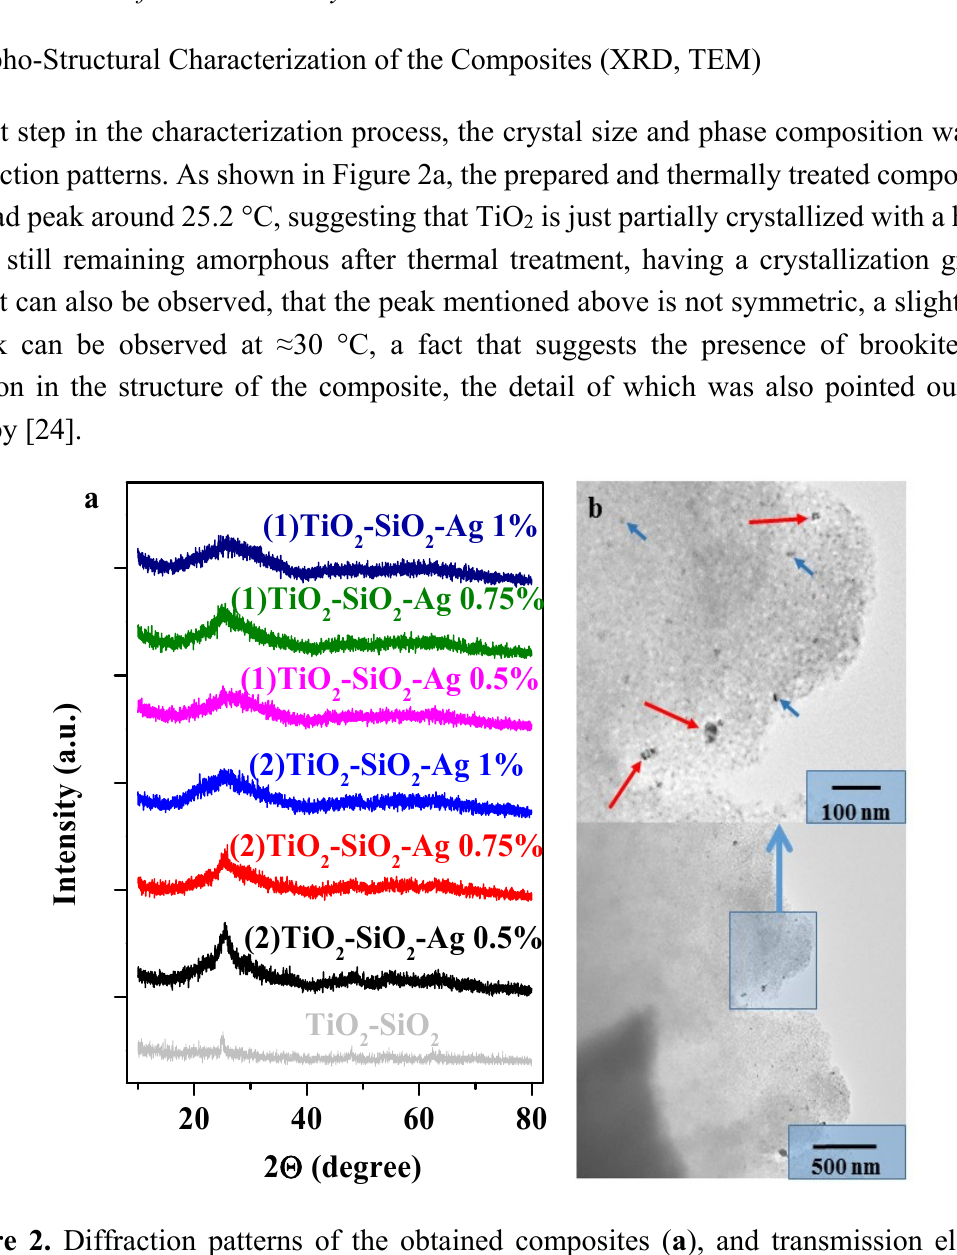
Figure 2. Diffraction patterns of the obtained composites ( a ), and transmission electron microscopy (TEM) micrograph of (2) TiO 2 -SiO 2 -Ag 1% (red arrows show the Ag aggregates, the blue arrows point out the single NPs) ( b